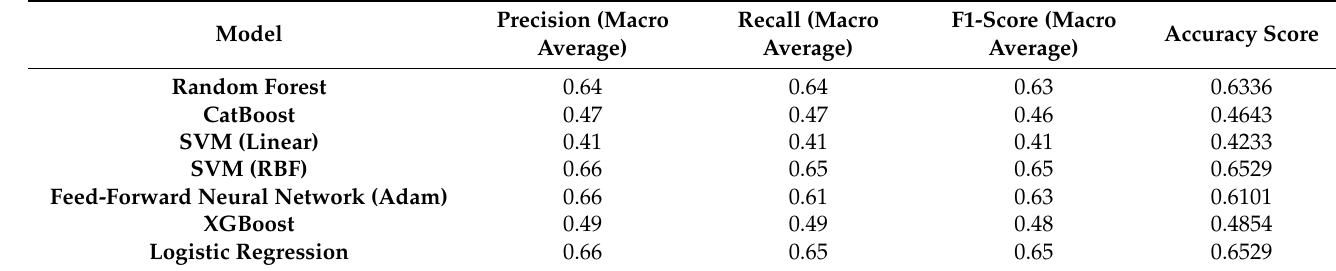
Table 6. Standalone machine-earning models trained on the Arabic character dataset.